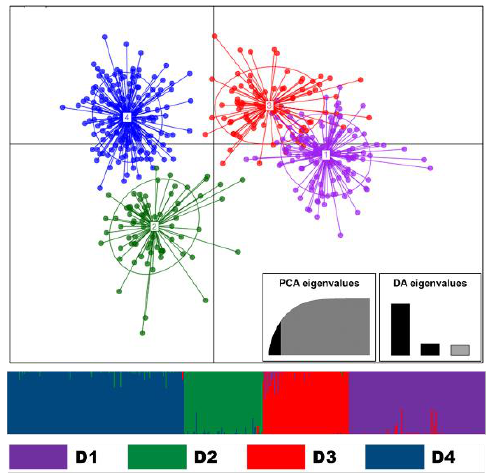
Figure 3. Discriminant analysis of the principal components (DAPC) for 462 tea accessions. The axes represent the first two Linear Discriminants (LD). Each circle represents a cluster, and each dot represents an individual. The numbers represent different subpopulations identified by the DAPC analysis.